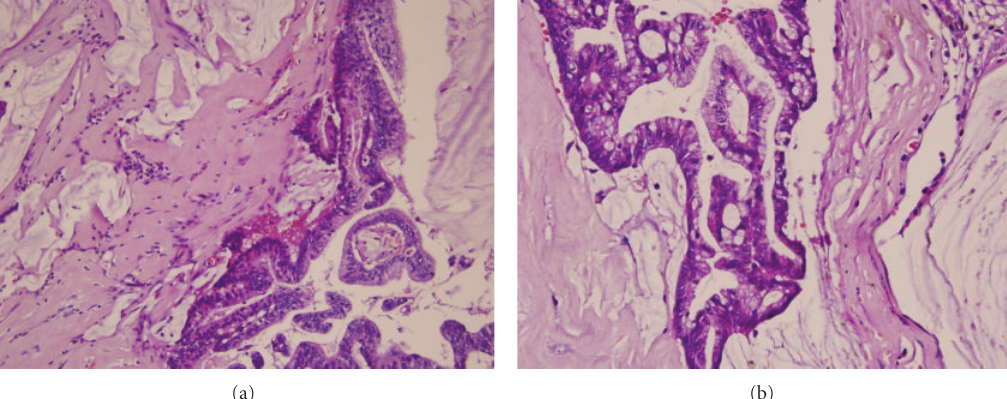
Figure 3: Adenoid structures formed by multilayer atypical epithelial cells and interstitial mucine